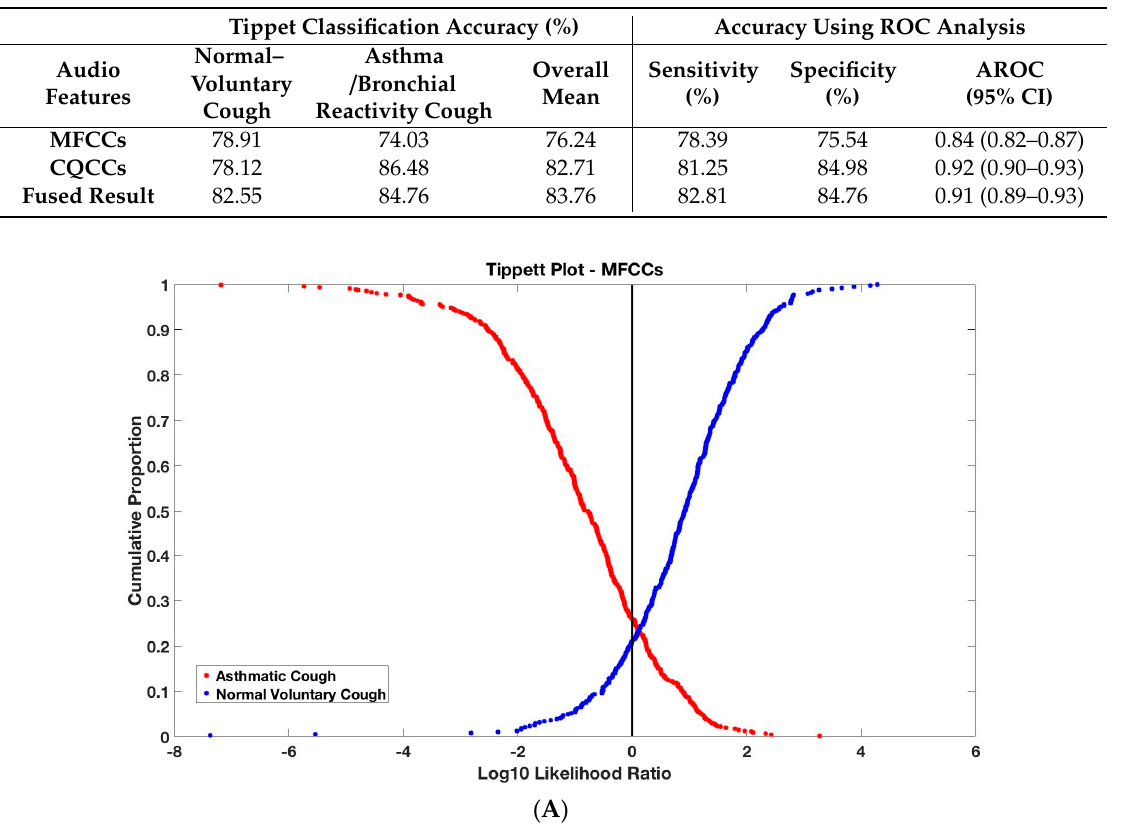
Table 4. Classification accuracy based on Tippet plot and Receiver Operating Characteristics (ROC) analysis.